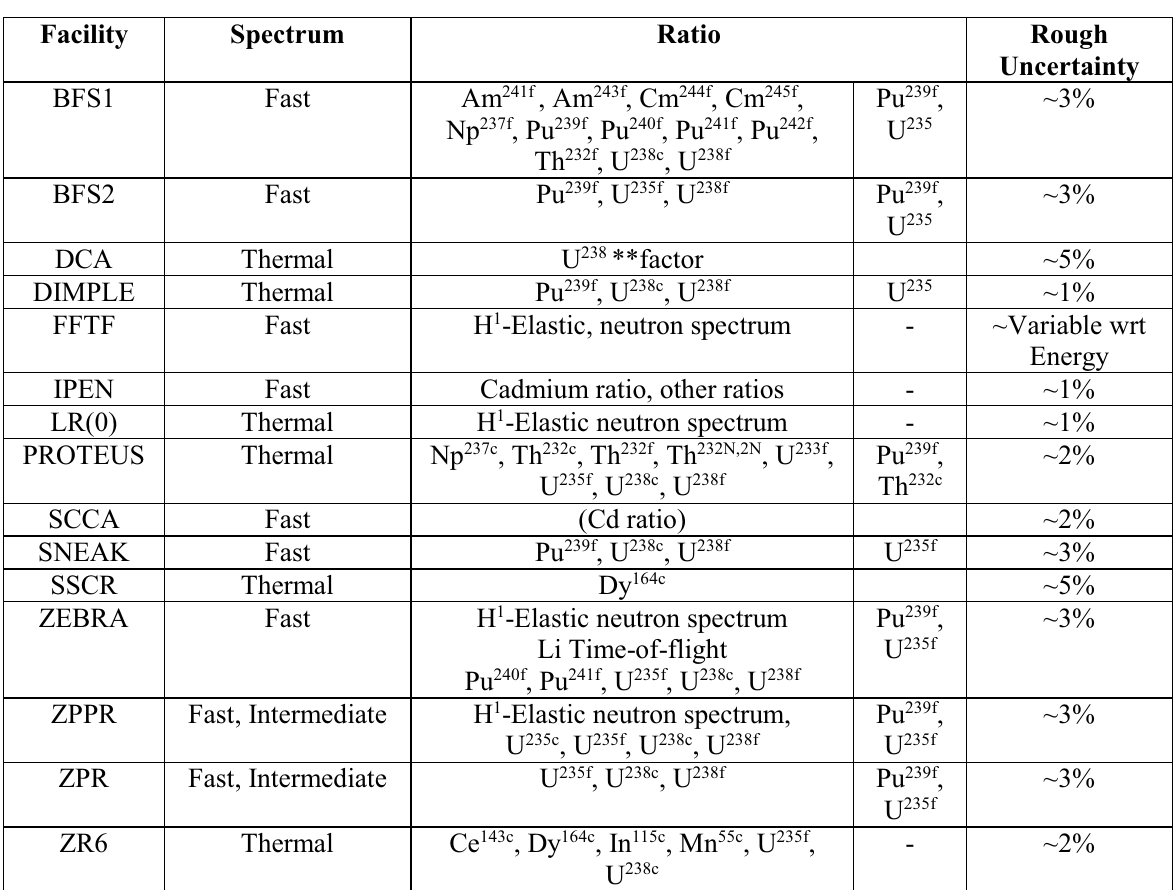
Table I.: Spectral characteristic experimental benchmarks in the IRPhEP